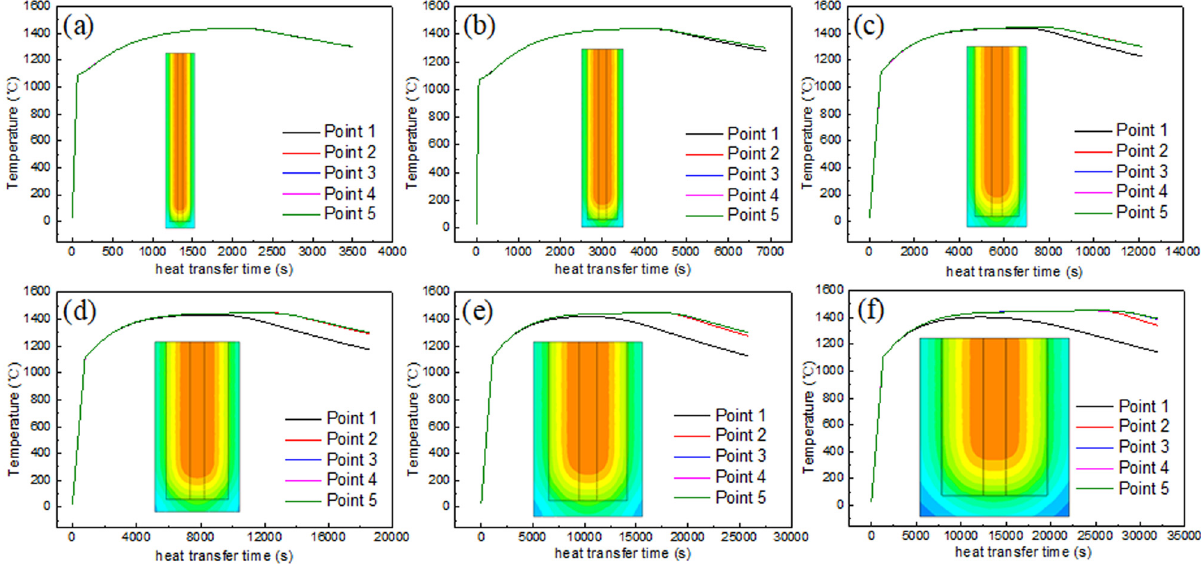
Figure 5: Variation of interfacial temperature of clad steel ingots with di ff erent diameters with time: ( a ) d = 150 mm; ( b ) d = 200 mm; ( c ) d = 250 mm; ( d ) d = 300 mm; ( e ) d = 350 mm; ( f ) d = 400